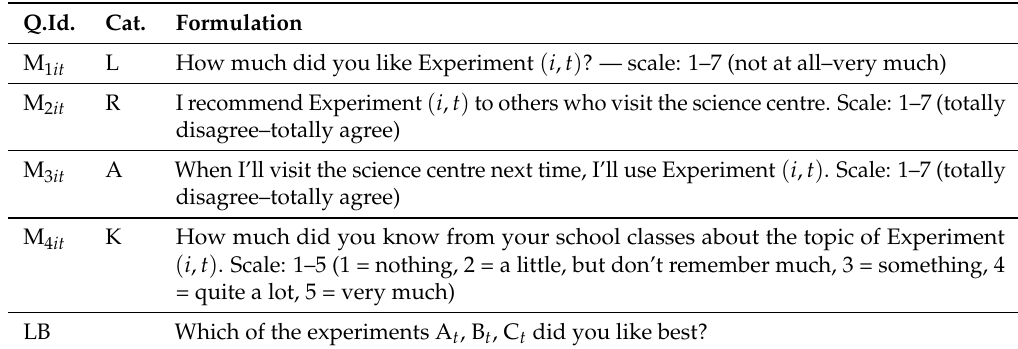
Table 4. Formulation of the questions and scales for experiment i and learning trail t . The second column indicates the category (L, like; R, recommend; A, use again; and K, knowledge). Q.Id.